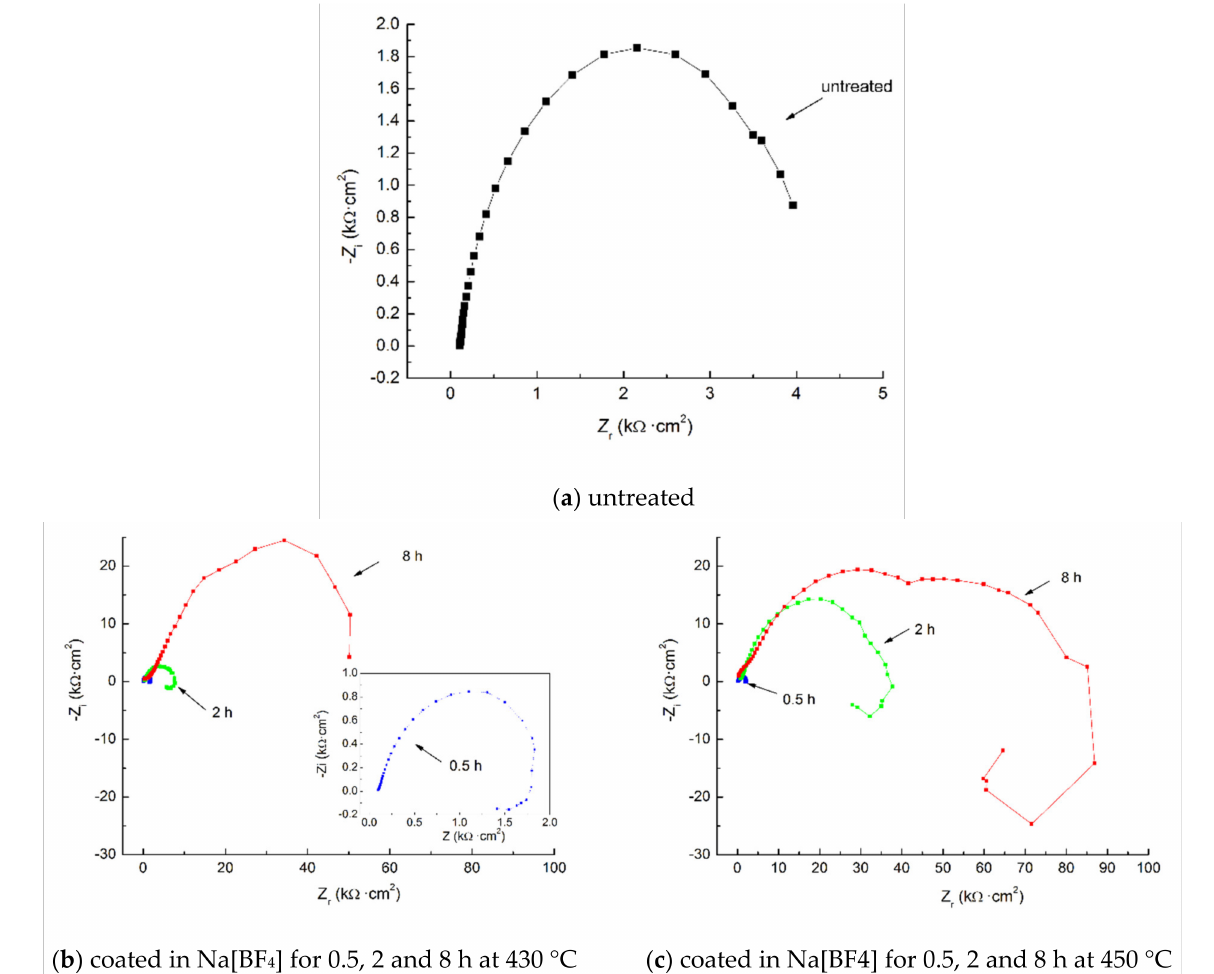
Figure 8. The Nyquist plots obtained after 168 h of immersion in SBF